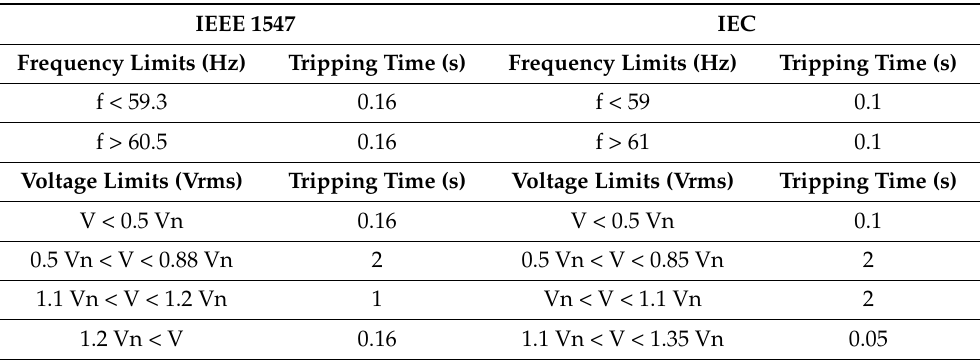
Table 2. Voltage and Frequency Limits for Islanding—IEEE vs. IEC Standard IEC [42]. IEEE 1547